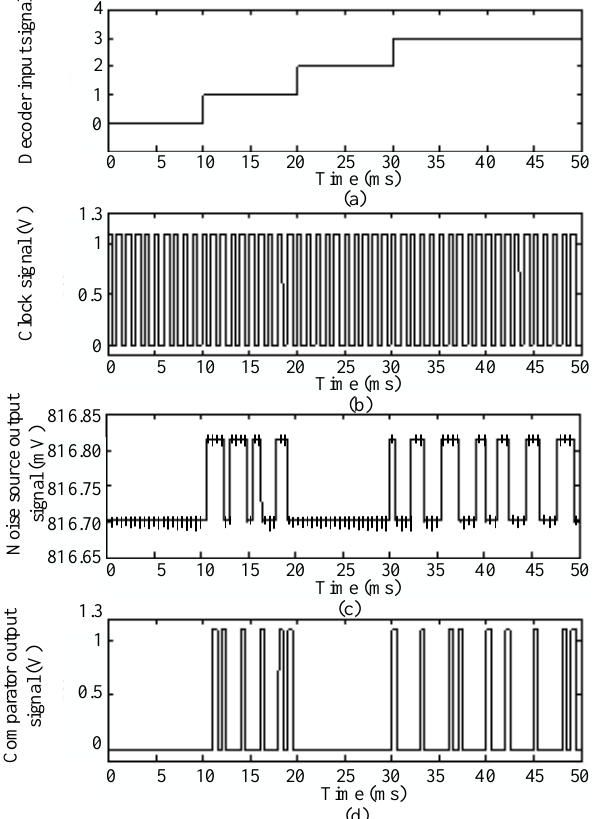
Figure 10. Digital-analog mixed post-simulation waveform.